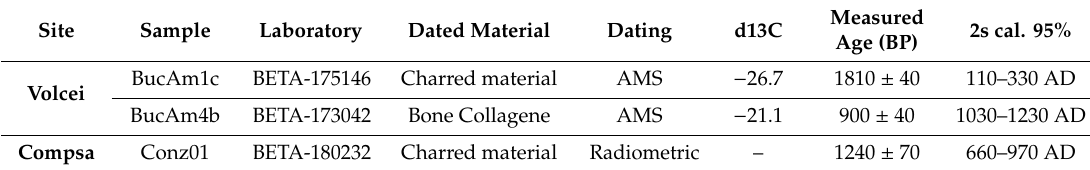
Table 1. Radiocarbon ages of samples collected in the investigated area (AMS, Accelerator Mass Spectrometry and Radiometric ages by Beta Analytic Inc., Miami, FL, USA). 2 σ calibration with software Calib 7.1